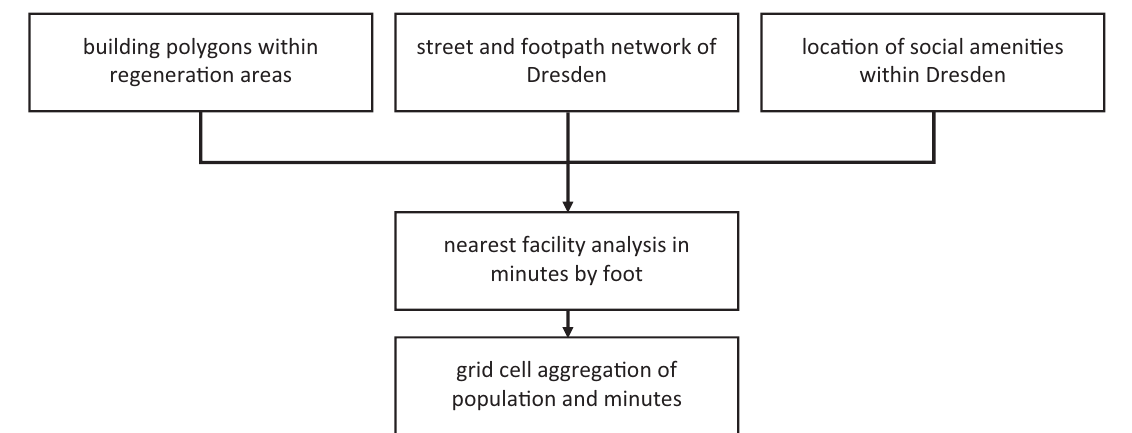
Figure 2. Workflow to estimate the accessibility of social